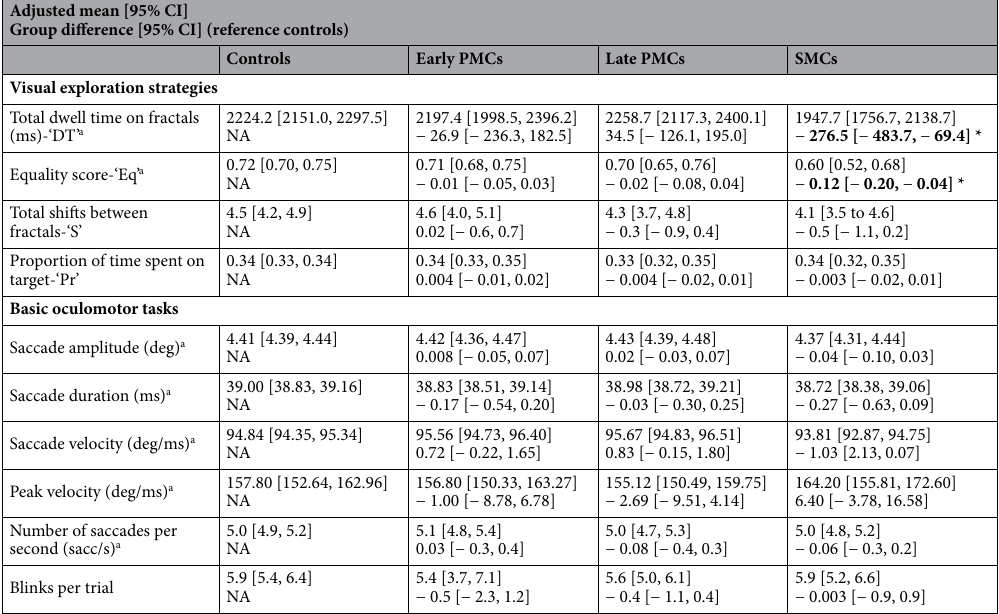
Table 2. Eye-tracking metrics by group. PMC presymptomatic mutation carrier, SMC symptomatic mutation carrier, NA not applicable. Bold = significant; *significant at p < 0.05 a From bias-corrected and accelerated (BCA)